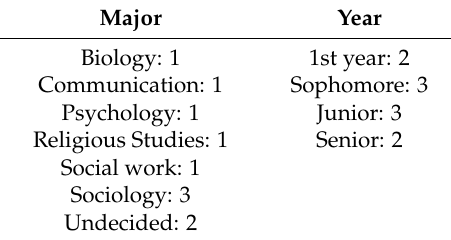
Table 3. African American Interviewees (all born in US) ( n = 10).